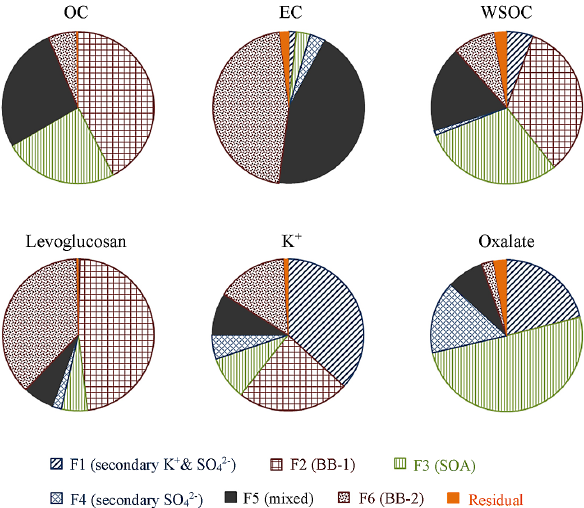
Fig. 7. Average source contributions to OC, EC, WSOC, levoglu- cosan, K + and oxalate estimated by PMF. Source apportionment results during the typical summer and typical winter periods are presented separately in the